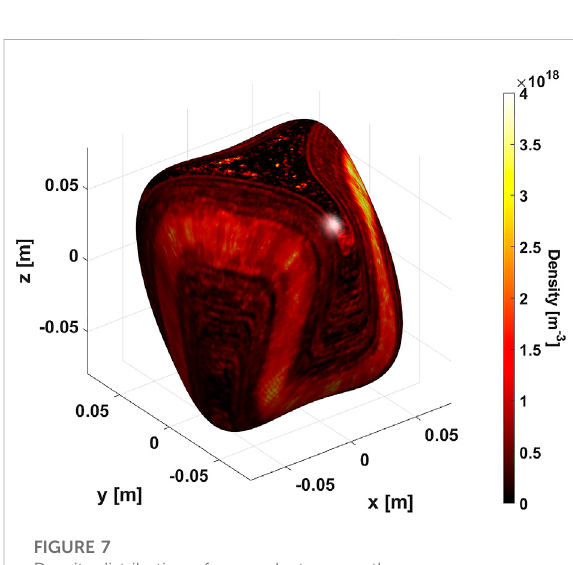
Density distribution of warm electrons on the resonance surface. The maximum of the color scale corresponds to the cut- off density at 18